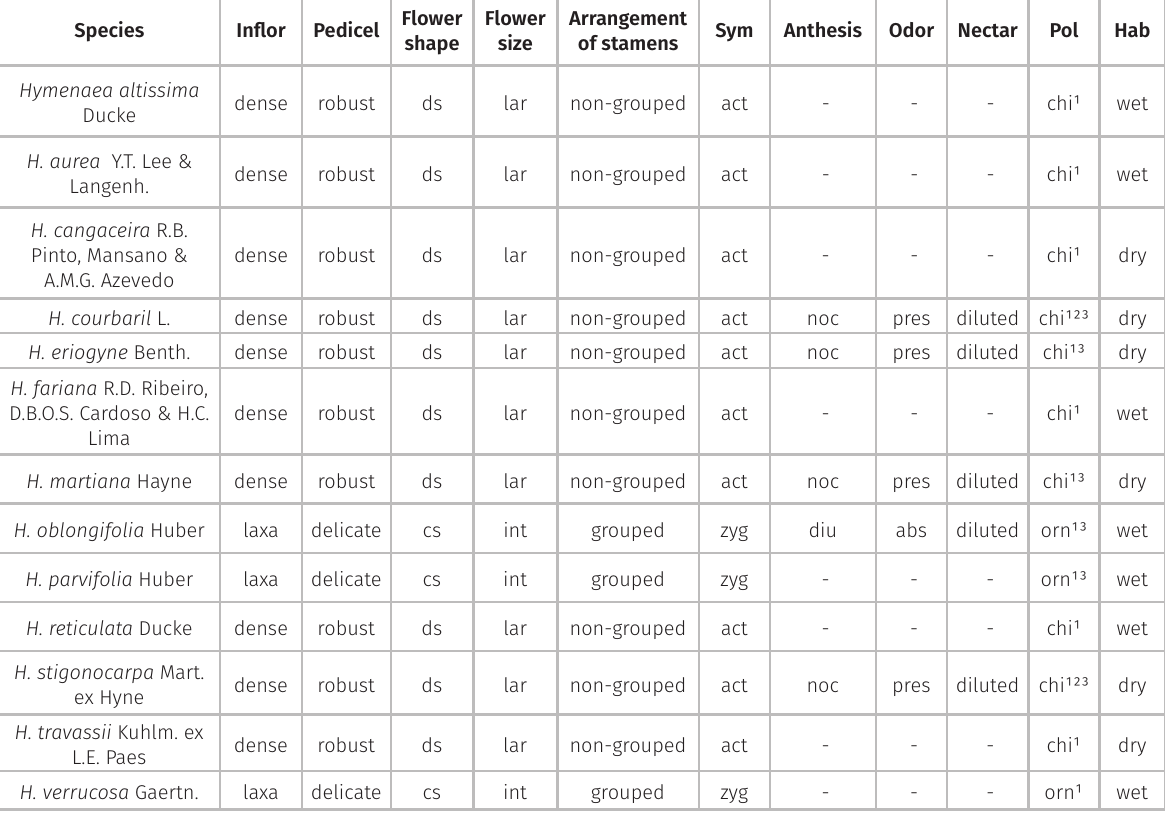
¹Pollination syndromes based on morphological attributes (Faegri & van der Pijl 1979); ²Pollination syndromes cited in the literature (Langenheim et al. 1973, Lee & Langenheim 1975, Arroyo 1981, Gibbs et al. 1999, Dunphy et al. 2004, Paiva & Machado 2008, Fleming et al. 2009); ³Pollination syndromes attested by field observations of I.M. Souza (unpublished